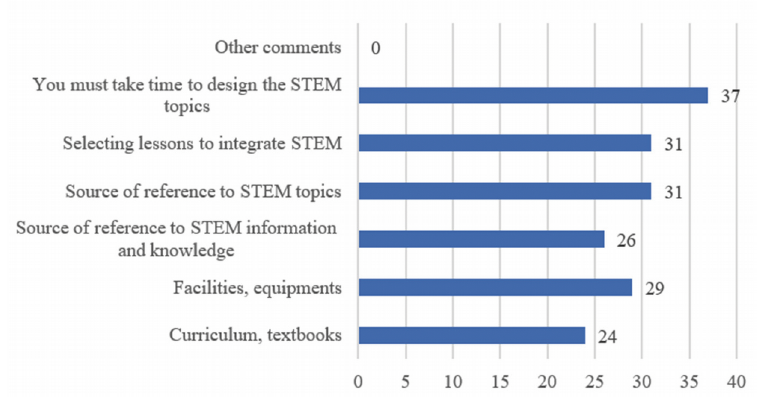
Figure 1. Difficulties in organizing Mathematics classes according to STEM education